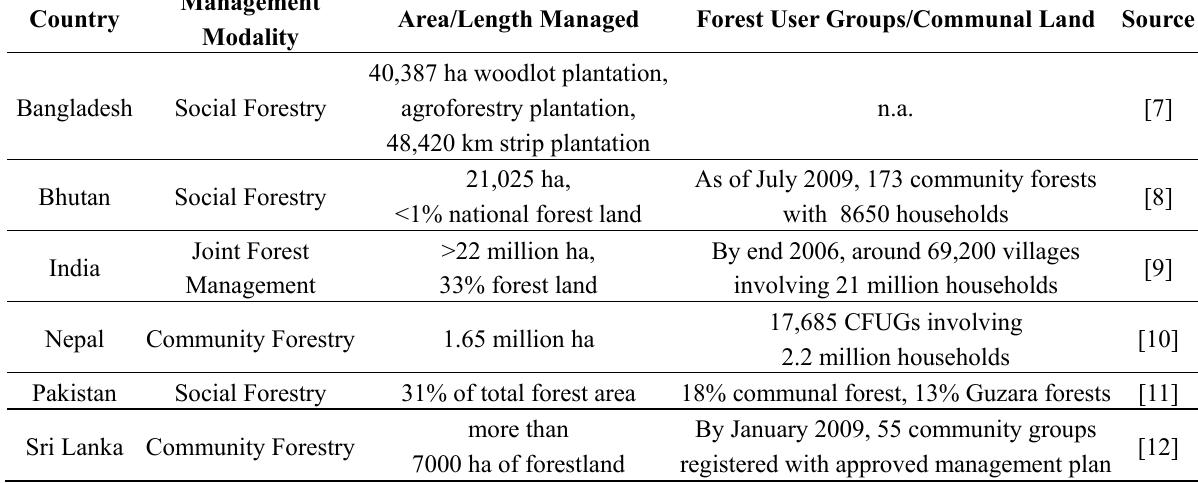
Table 2. Community-managed forests in SAARC